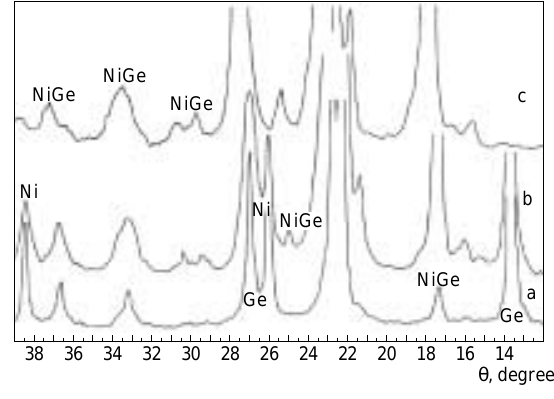
Fig. 5 X-ray patterns of Ni 55 wt.% Ge mixture after mechanical activation during 1 (a), 7 (b), 25 min.